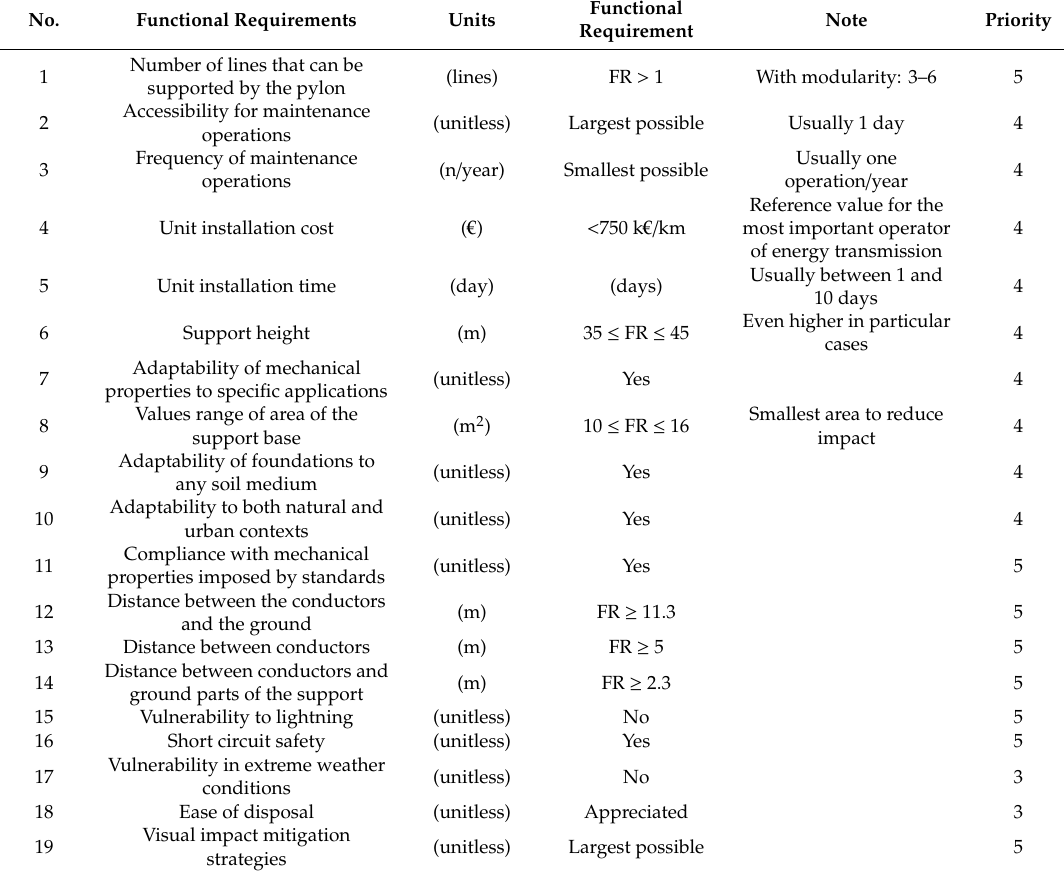
Table 1. Technical specifications for a pylon of a 380-kV electricity